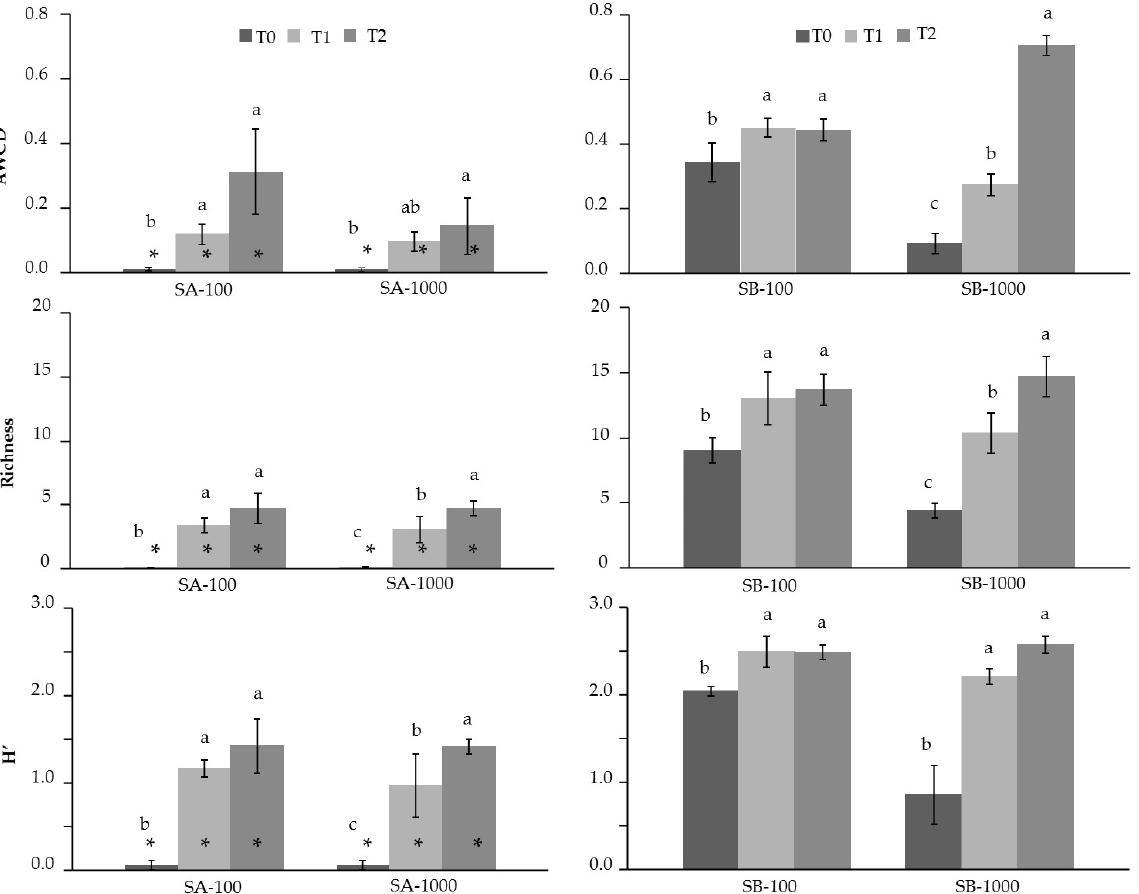
Figure 4. Biolog AWCD, richness and H’ (Shannon–Weaver) index in amended and unamended Sb-polluted SA and SB soils. Average values (histograms) and standard errors (bars) relative to the 120 h incubation time are reported. T0, T1 and T2 refer to MSWC addition, i.e., 0, 1 and 2%, respectively. For each soil (SA and SB) and Sb concentration level, different letters denote significant differences between treatments (Tukey–Kramer test; p < 0.05). For each Biolog-derived parameter, asterisks denote significant differences between SA-100 and SB-100, and between SA-1000 and SB-1000 (Student t-test; p < 0.05).